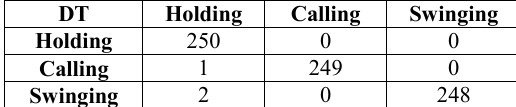
Table 1. The confusion matrix for smartphone modes